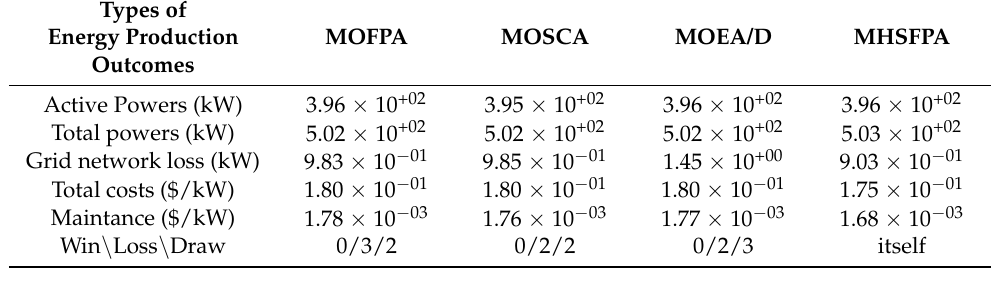
Table 8. The output results of three multi-object approaches: the MHSFPA, MOFPA, MOCSA, and MOEA/D algorithm with a selected specific point.